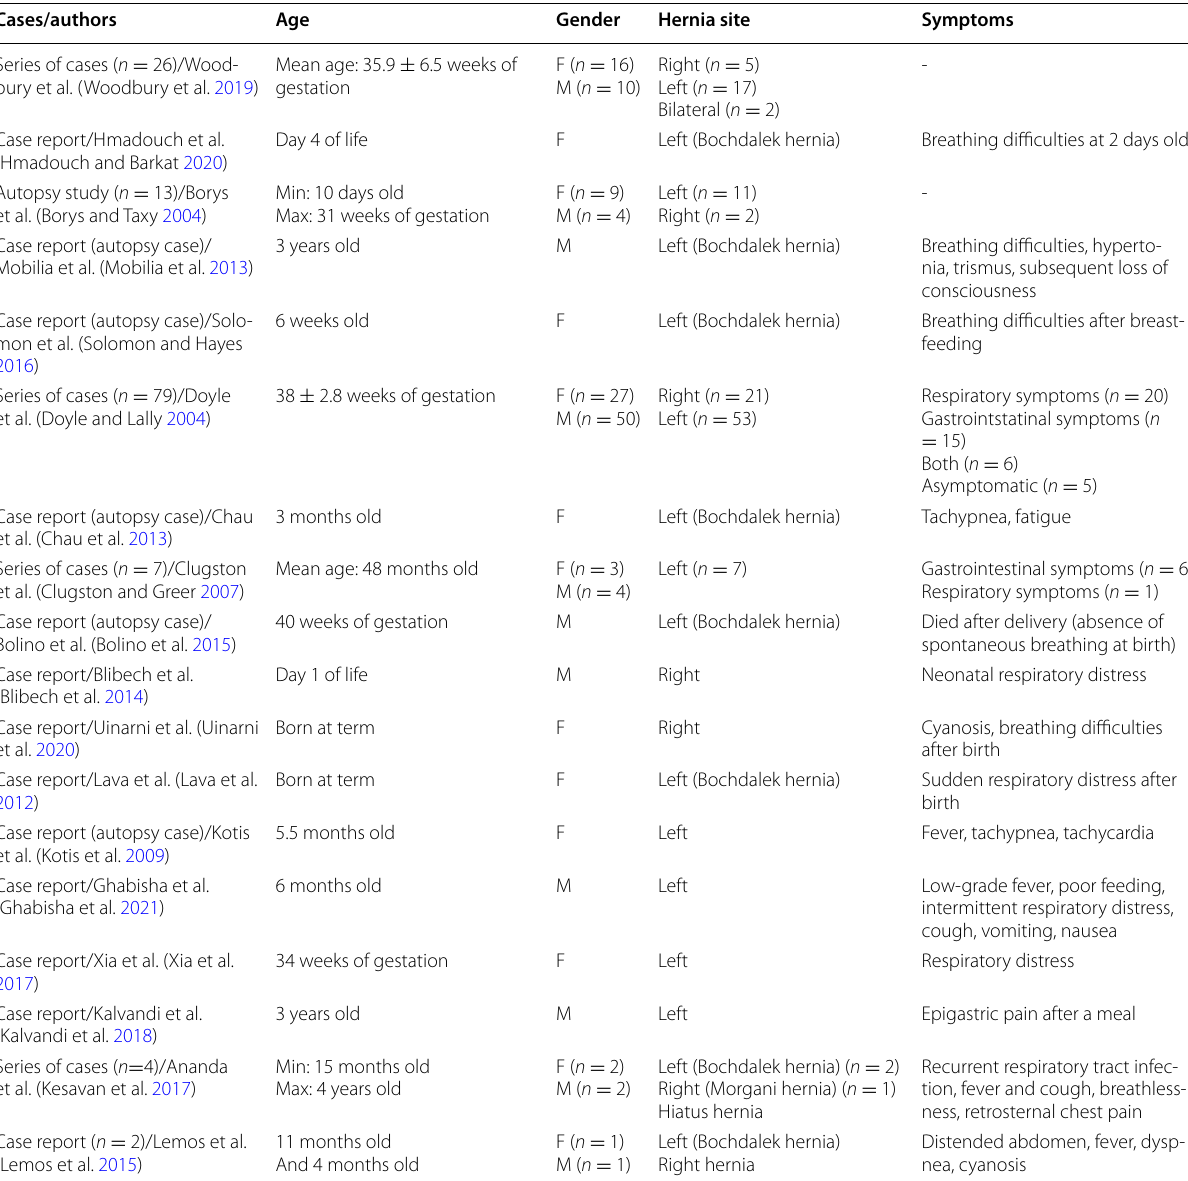
Table 1 Literature review of neonatal and pediatric